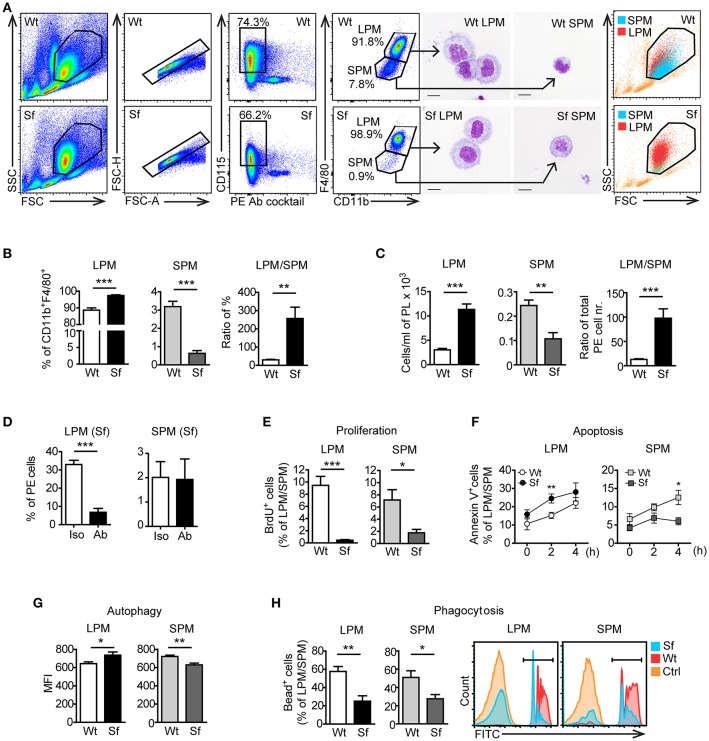
Peritoneal macrophage subsets and their effector functions are skewed due to the absence of regulatory T cells. (A) Gating strategy used to identify large peritoneal macrophages (LPM) and small peritoneal macrophages (SPM) by flow cytometry. Cells were FACS sorted and stained with May-Grünwald/Giemsa. Data shown are representative from >10 experiments. (B) Percentages (n = 8) and (C) total cell numbers (n = 5–6) of CD115+CD11bhighF4/80high LPM and CD115+CD11bintF4/80int SPM in the peritoneal exudate of scurfy (Sf) and littermate control (Wt) mice determined by flow cytometry. (D) Percentages of LPM and SPM in Sf mice within PE after injection of anti-M-CSF antibody (Ab) or isotype (Iso) control antibody (n = 5 mice, data are pooled from two independent experiments). Flow cytometry analyses of (E)
in vivo proliferation (n = 4, one representative experiment out of three), (F) apoptosis (Annexin V staining; n = 8–11 per time-point), (G) autophagy (n = 5-6), and (H) phagocytosis rate in vivo (n = 5) of LPM and SPM in Sf and Wt mice. Statistical analyses were performed using unpaired Student's t-test, *p < 0.05, **p < 0.01, ***p < 0.001.